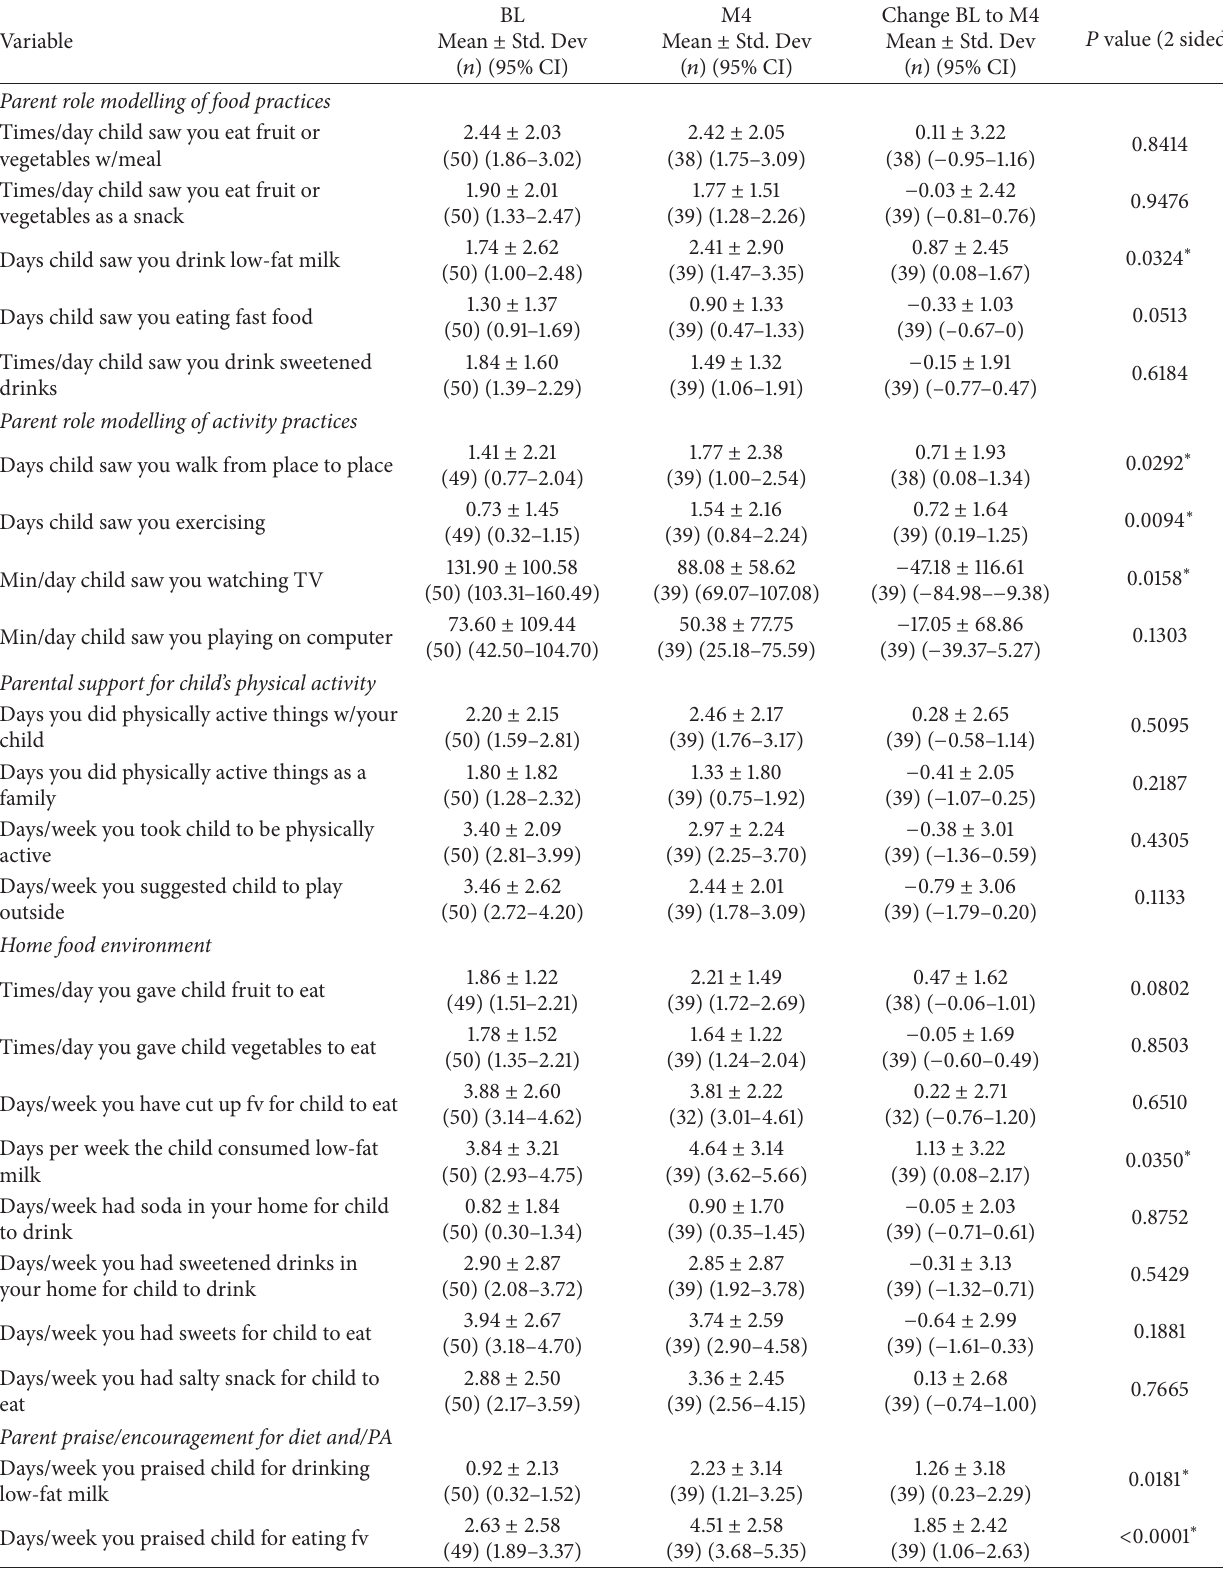
Table 4: Changes in parent behaviors from baseline to month 4 and change scores for healthy homes, healthy families